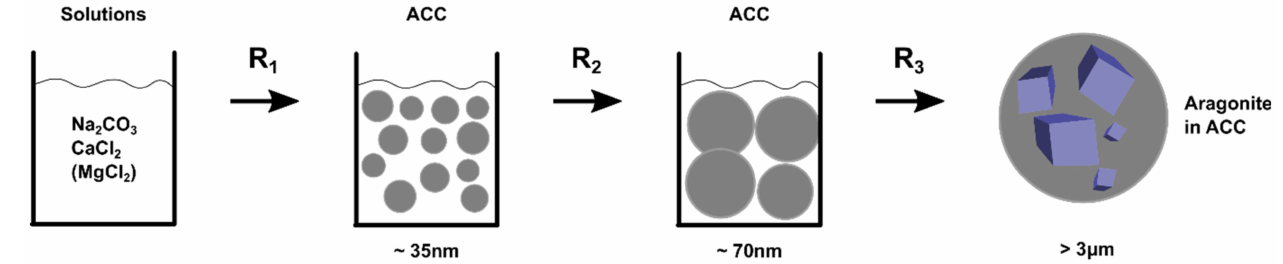
Figure 7. Schematic diagram summarizing the average particle pathway from solution to crystal for calcium carbonate, as observed in this